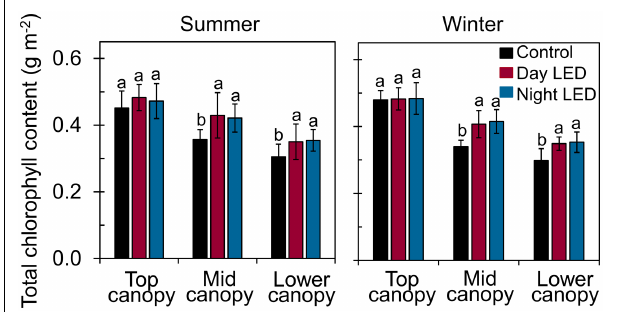
FIGURE 4 | Total chlorophyll content of single-truss tomato leaves. Chlorophyll was measured from leaves at each level of the canopy (top, middle, and lower canopy) in plants grown under daytime or nighttime LED inter-lighting and controls, during both summer and winter. Data represent means ± SE ( n = 15). Different letters indicate statistically significant differences (Tukey’s HSD at P < 0.05).